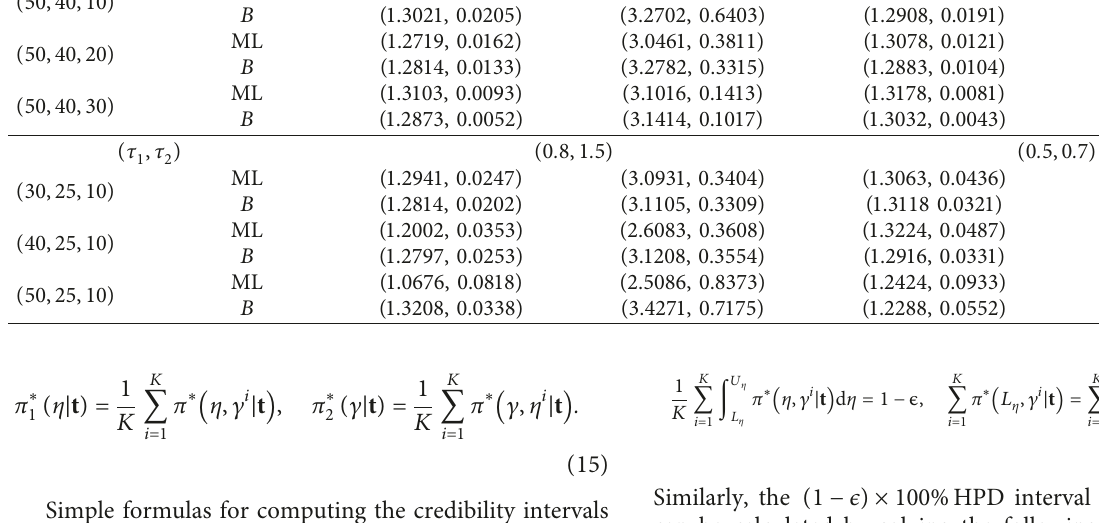
Table 1: Parameters point estimates and its related MSE s using ( η � 1 . 2951 , c � 3 . 1627 ) , ( c